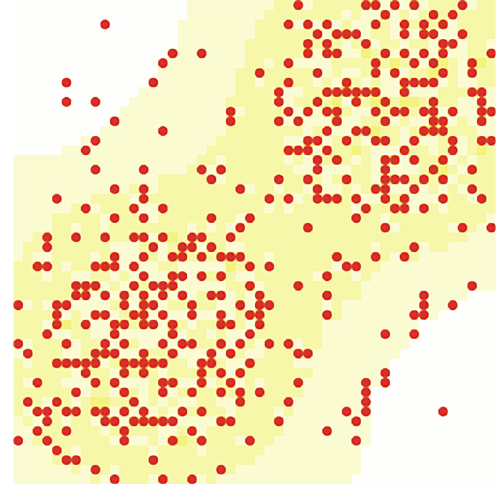
Figure 2. A Sugarscape implementation from the NetLogo Models